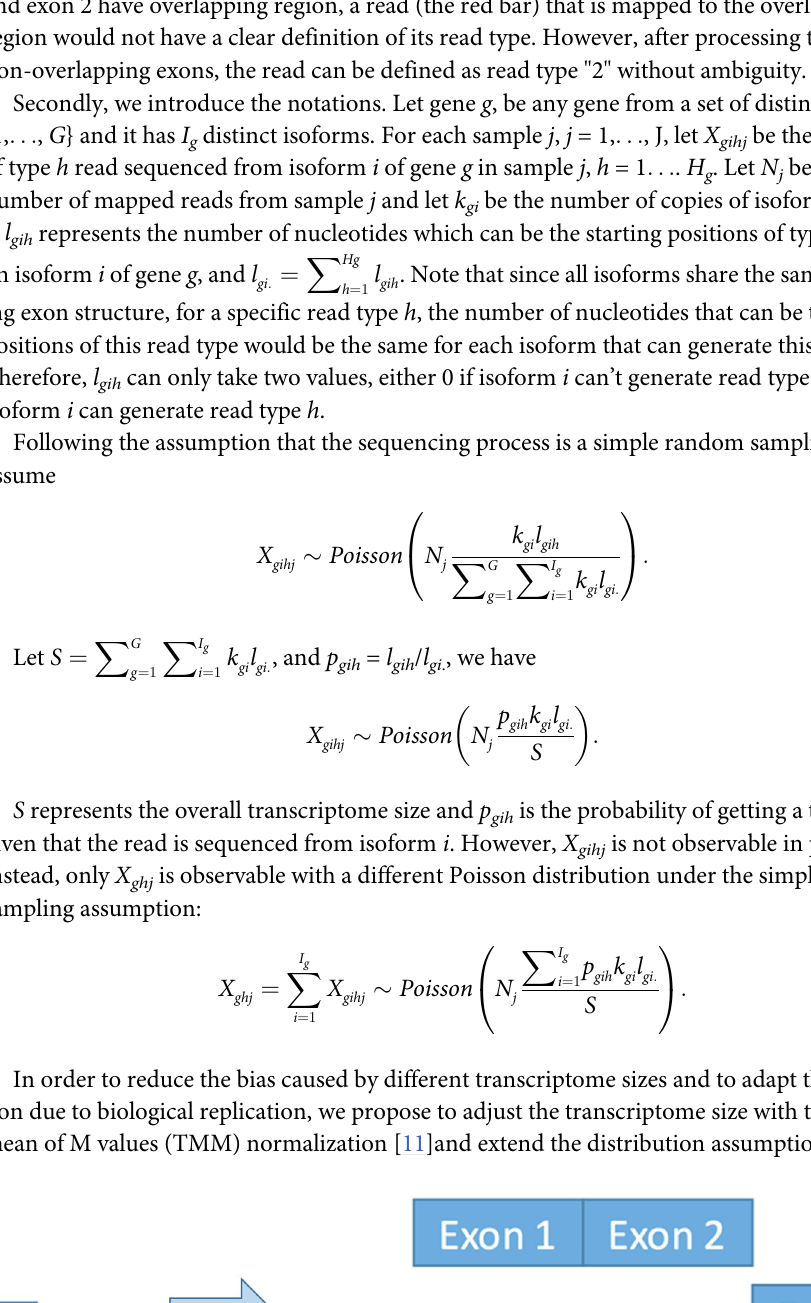
PLOS ONE | https://doi.org/10.1371/journal.pone.0266162 May 16,